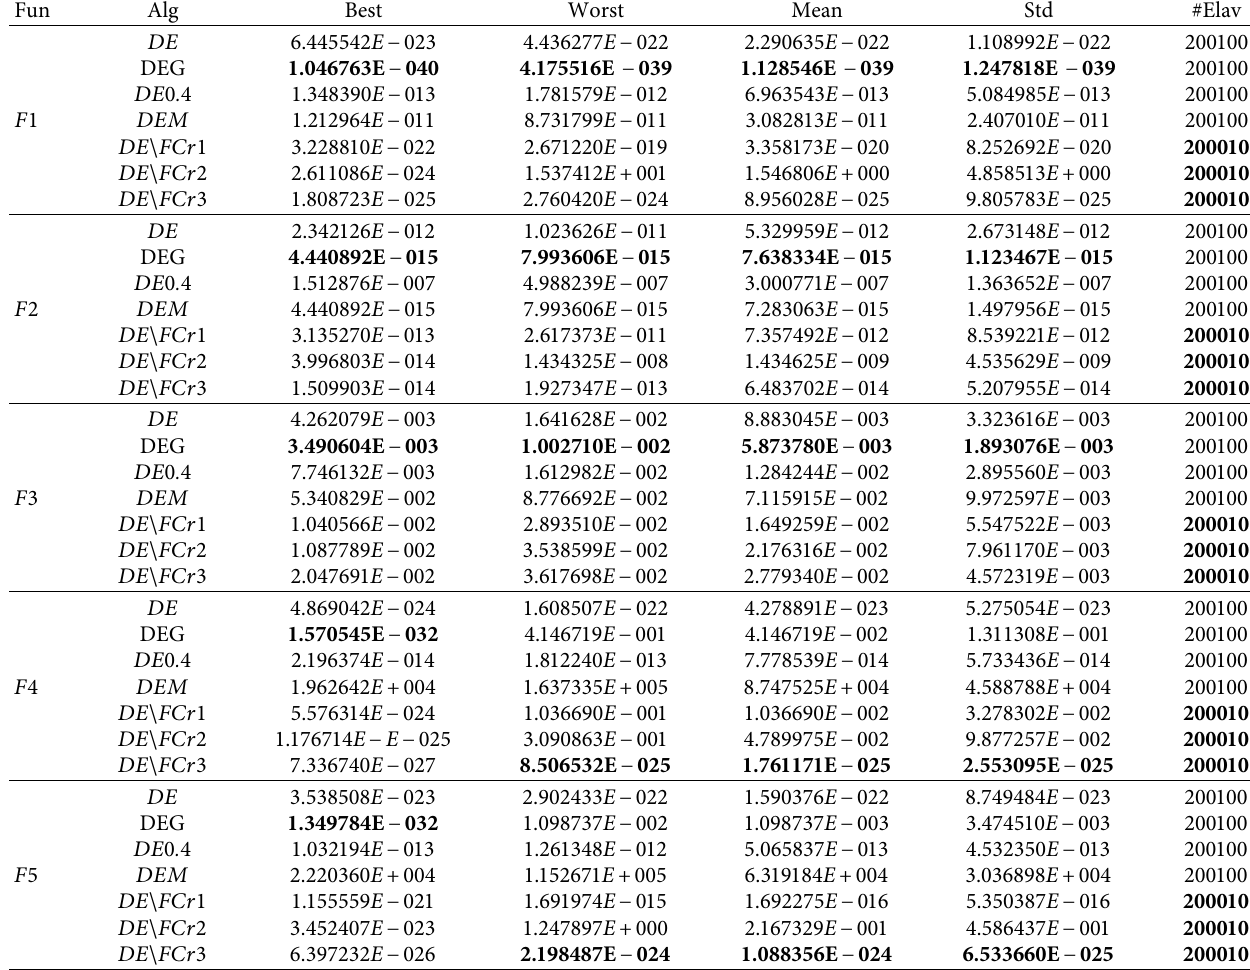
Table 3: Result comparisons among 7 algorithms for F 1– F